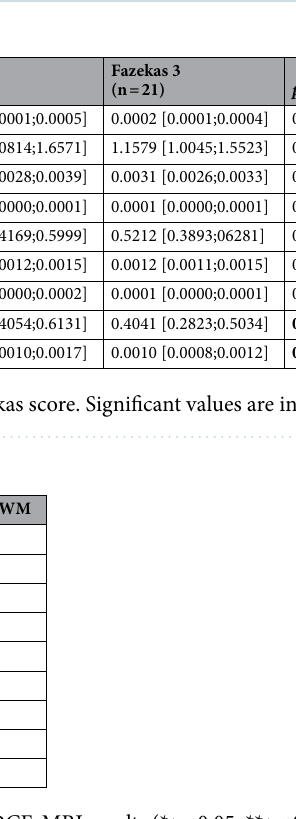
Table 6. Correlation between ABPM results and DCE-MRI results (* p < 0.05, ** p < 0.01). Significant values are in bold.